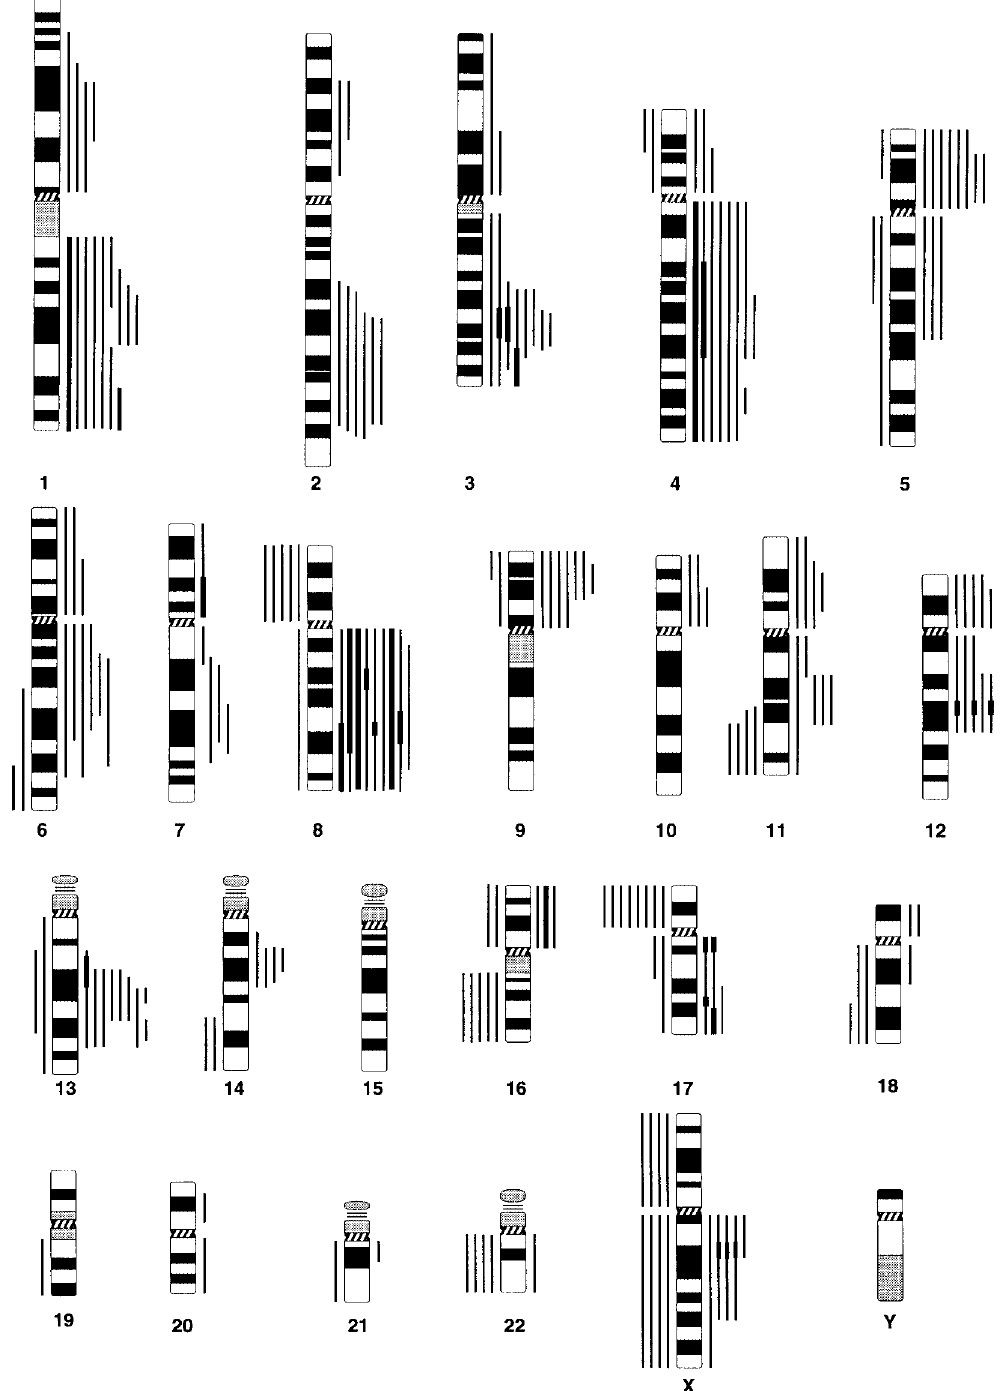
Fig. 2. Karyogram of chromosomal gains and losses in primary breast carcinomas ( n = 16). All tumors were between 11–20 mm in size (T1c) and bars on the right side of the chromosome ideogram indicate gains and bars on the left side indicate loss of genetic material. Solid bars denote high-level copy number increases